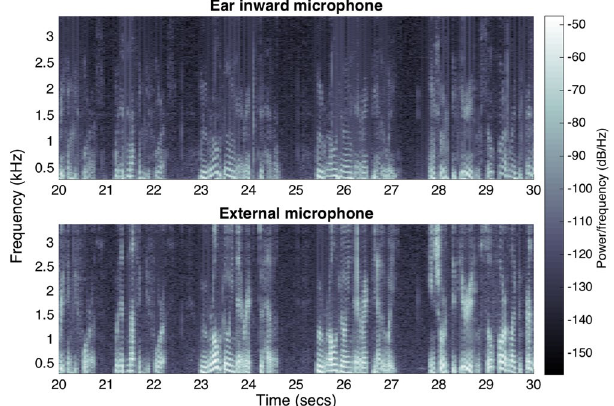
Figure 6. Recording of speech from the multimodal earpiece, illustrated through a 10 s spectrogram. (Top) Speech signal recorded using a microphone placed on the tip of the earpiece looking towards the eardrum. (Bottom) Speech signal from an external microphone placed on a subject’s chest. The Y-axis for both spectrograms spans the 300–3400 Hz band, the so-called voice frequency band.